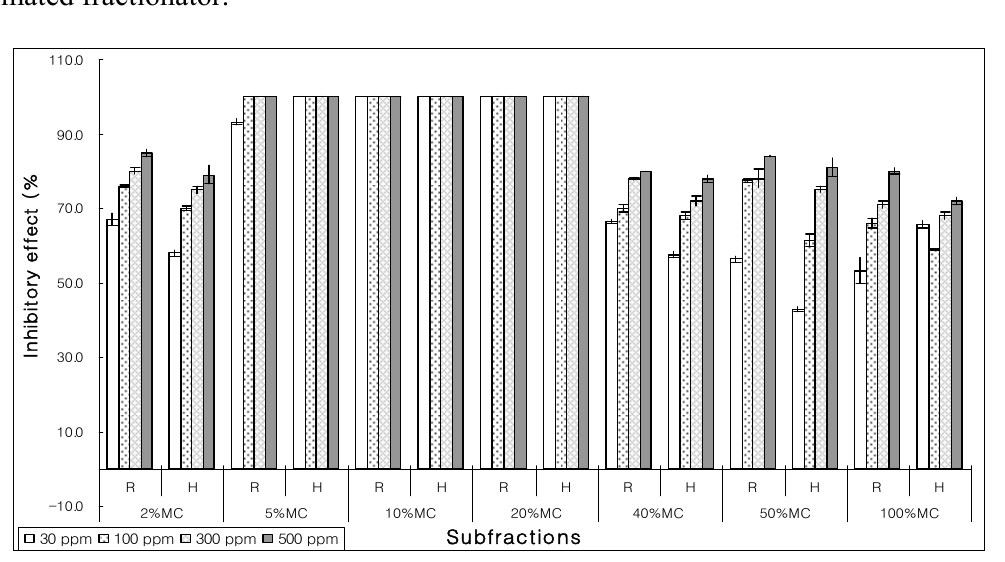
Figure 4. Pattern of allelopathic effect on the growth of root (R) and hypocotyls (H) of bioactive 5% methanol: chloroform (MC) using a silica gel column equipped with an automated fractionator.